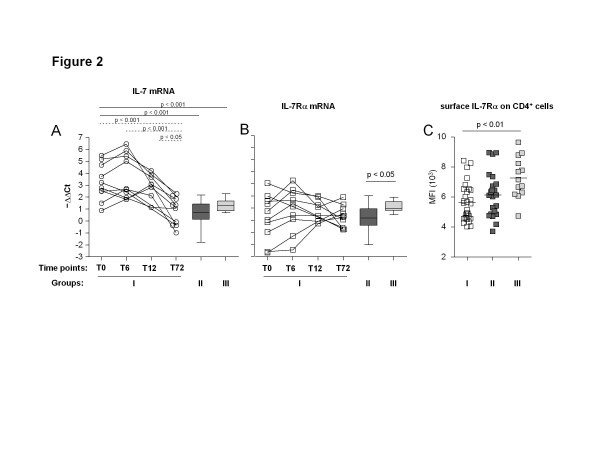
Quantification of IL-7 and IL-7Rα mRNA and IL-7Rα cell surface expression. (A) Quantification of IL-7 mRNA in PBMCs of 10 HIV-1+ patients that initiated cART and were thereafter followed up for 72 months (group I, from T0 to T72), of 18 HIV-1+ patients that did not require therapy (group II), and of 11 uninfected subjects (group III). Values measured in individual patients are shown as clear circles. Dashed significance lines indicate the results of the longitudinal analysis within patients of group I. (B) RNA expression of IL-7Rα in PBMCs of patients of groups I, II and III. Values measured in individual patients are shown as clear squares. (C) Surface expression of IL-7Rα on CD4+ cells in the three groups of subjects as determined by flow cytometry; statistical analysis performed by ANOVA followed by the Bonferroni test.